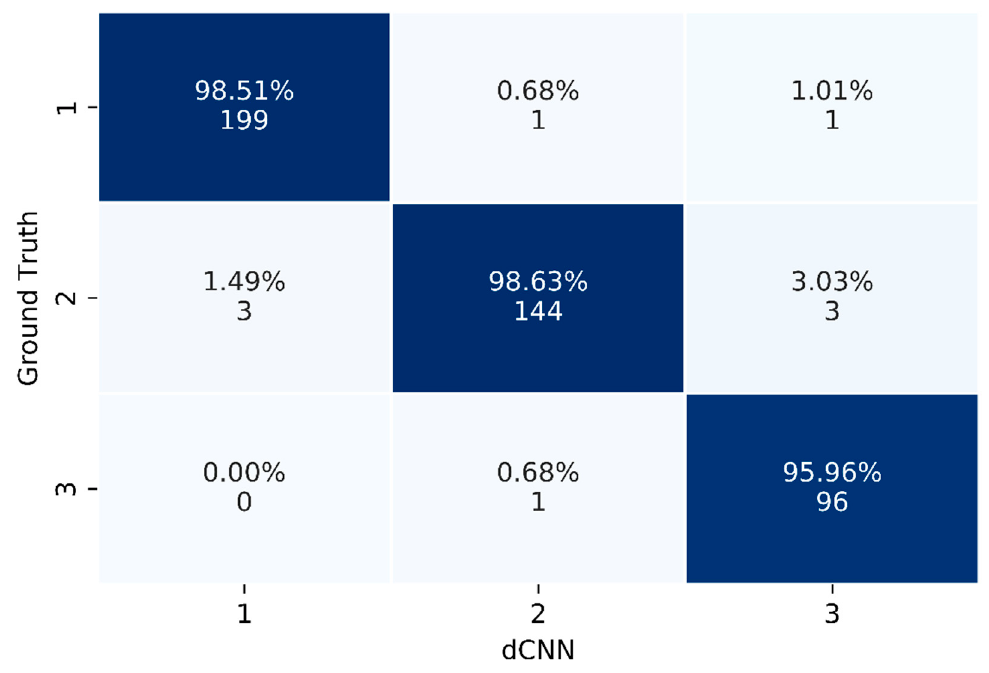
Figure 4. Confusion matrix of the “real world” test set calculated by the dCNN in comparison to the ground truth (radiological report). Blue marked elements highlight correctly assessed images.